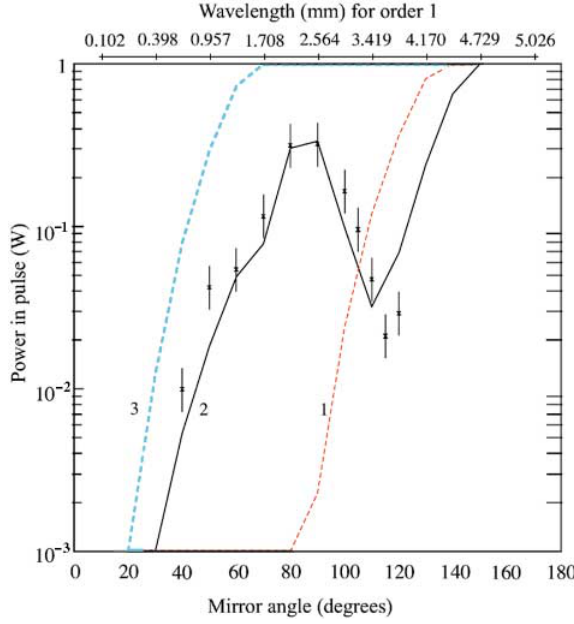
FIG. 5. (Color) Experimental data points, fitted with various lon- gitudinal profiles, all containing 85% of the bunch particles in- side 14 ps. 1: Gaussian; 2: triangular with asymmetry factor e (cid:1) 1.1 ; and 3: exponential. 072802-5